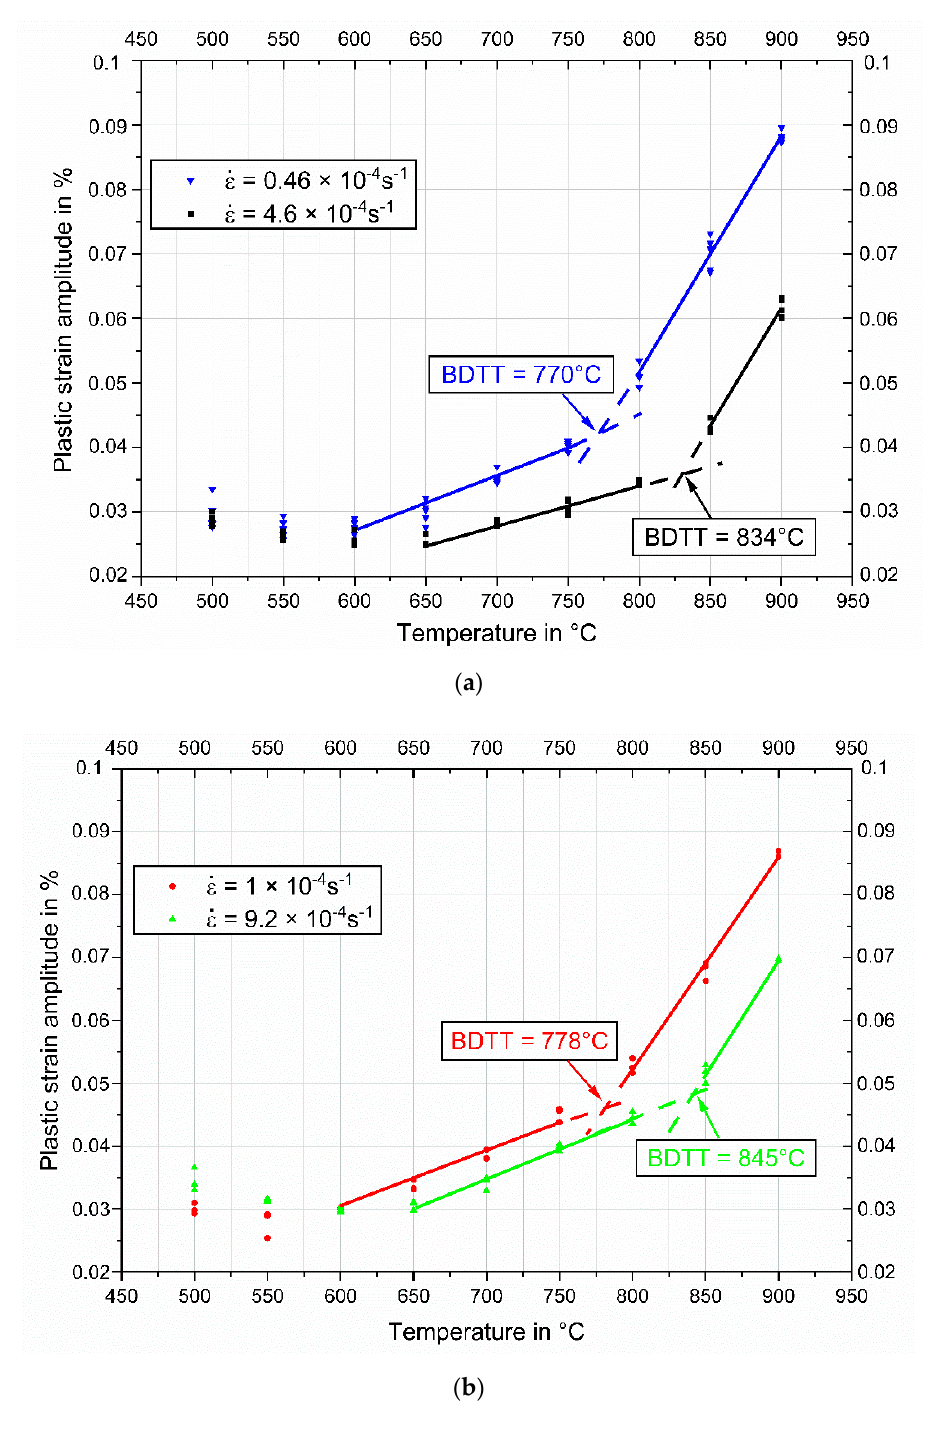
Figure 5. The resulting plastic strain amplitudes for di ff erent strain rates. ( a ) determination of BDTT at the strain rates of 0.46 × 10 − 4 s − 1 and 4.6 × 10 − 4 s − 1 ; ( b ) determination of BDTT at the strain rates of 1 × 10 − 4 s − 1 and 9.2 × 10 − 4 s − 1 . Table 3. BDTT of Ti-48Al-2Nb-0.7Cr-0.3Si Alloy at Different Strain Rates.